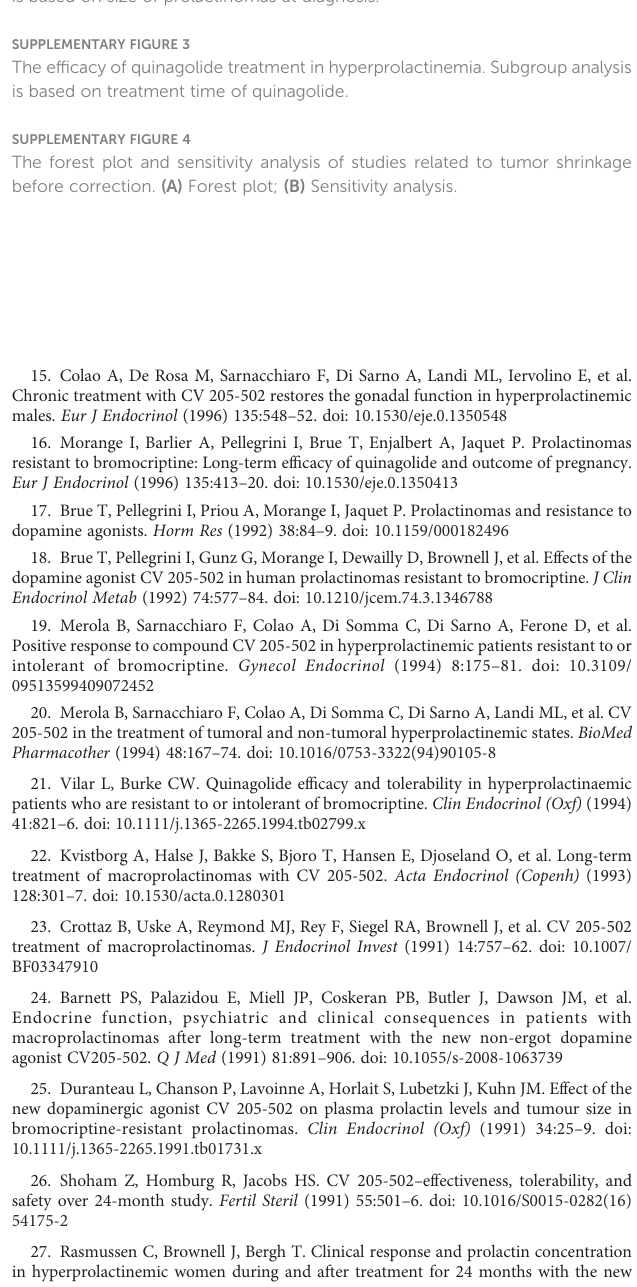
SUPPLEMENTARY FIGURE 1 The ef fi cacy of quinagolide treatment in hyperprolactinemia. Subgroup analysis is based on different level of initial serum prolactin concentration. SUPPLEMENTARY FIGURE 2 The ef fi cacy of quinagolide treatment in hyperprolactinemia. Subgroup analysis is based on size of prolactinomas at diagnosis. SUPPLEMENTARY FIGURE 3 The ef fi cacy of quinagolide treatment in hyperprolactinemia. Subgroup analysis is based on treatment time of quinagolide. SUPPLEMENTARY FIGURE 4 The forest plot and sensitivity analysis of studies related to tumor shrinkage before correction. (A) Forest plot; (B) Sensitivity